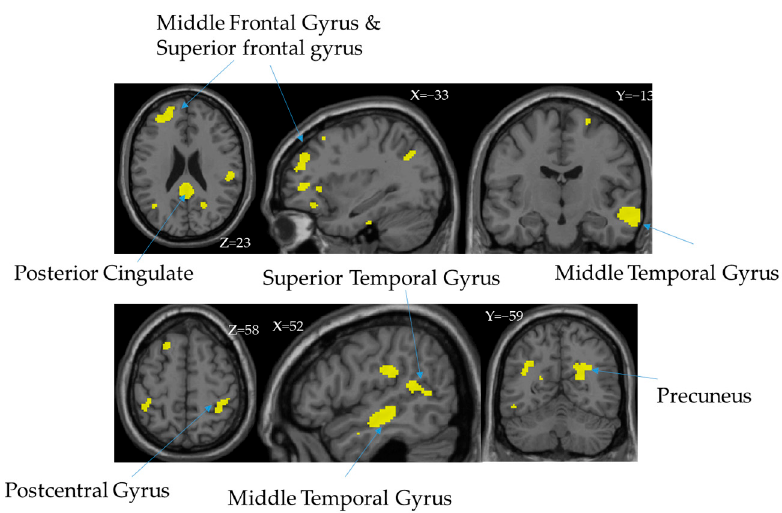
Figure 2. Conceptual illustration to present possible relation between brain regions and